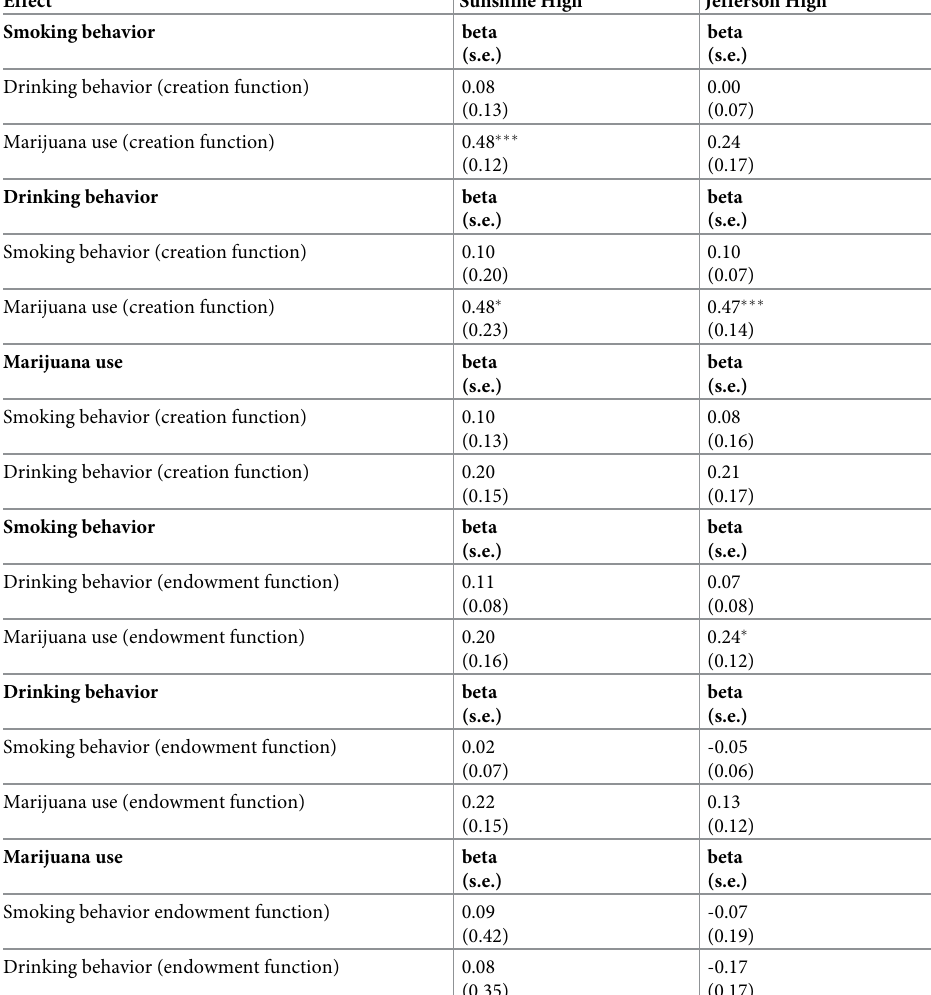
Table 3. Stochastic actor-based models decomposing interdependent substance use into increases (creation func- tion) and decreases (endowment